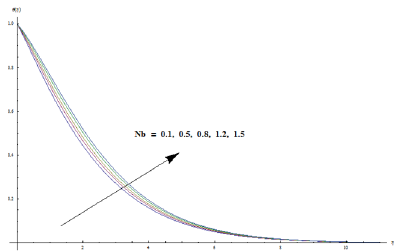
Figure 8. Variation in dimensionless temperature h ( g ) vs g for different values of Rd when l 1 ~ 0 : 3, b ~ 0 : 2, M ~ 0 : 5,